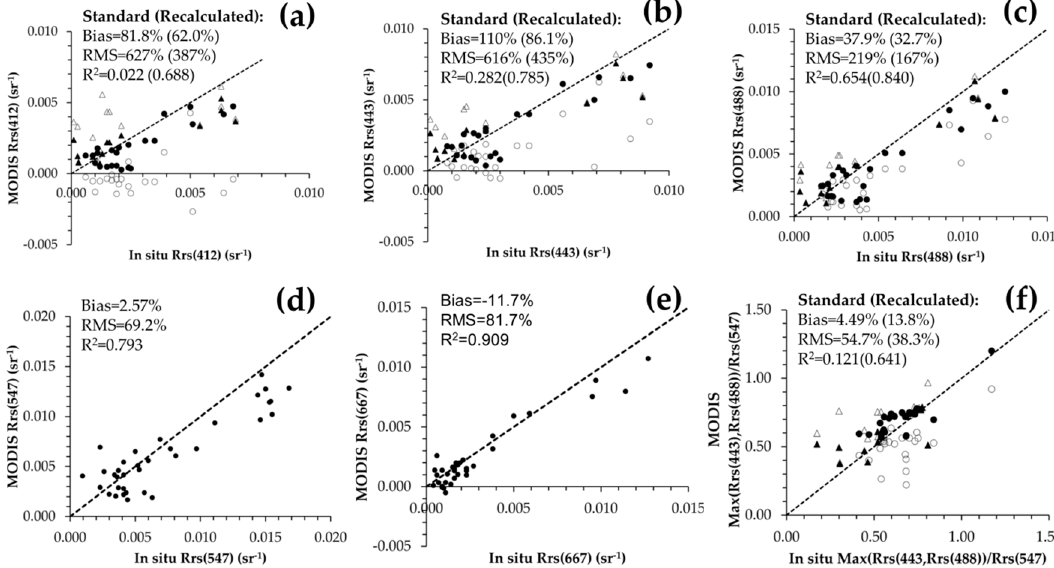
Figure 3. Scatter diagrams of in situ Rrs versus MODIS Rrs for ( a ) 412 nm, ( b ) 443 nm, ( c ) 488 nm, ( d ) 547 nm, ( e ) 667 nm, and ( f ) an OC3M band ratio. Triangles and circles in ( a – c , f ) represent cases where the standard MODIS Rrs(412) was smaller or larger than the Rrs(412) estimated from Rrs(547), respectively. Unfilled and filled symbols in ( a – c , f ) represent standard and recalculated data, respectively. Dashed black line is Y = X.